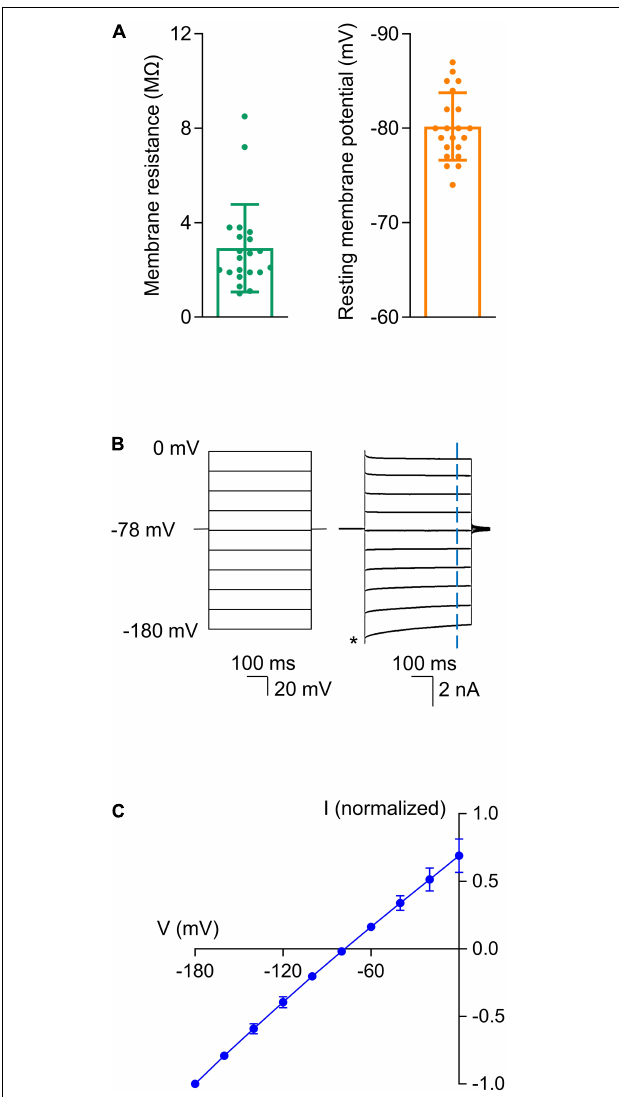
FIGURE 1 | Astrocytes displayed unique electrophysiological properties. After the whole-cell patch configuration was achieved, cells were confirmed to be astrocytes based on their low membrane resistance, hyperpolarized resting membrane potentials, and linear I-V relationships. (A) Summarized data for membrane resistance and resting membrane potential ( n = 21). (B) Linear I-V relationship of the astrocytes. Representative recordings show current responses (Right) to voltage steps (500 ms) that ranged from -180 to 0 mV in 20 mV increments (Left). The cell was held at -78 mV between voltage commands. Current amplitudes were measured 435 ms after initiation of each step voltage as indicated by the vertical blue dash line. The amplitudes were normalized to that at -180 mV as indicated by the asterisk. (C) Summarized I-V plot. Each data point represents the mean of values from 21 recorded astrocytes. The reversal potential obtained from the fitted I-V plot was -78 mV. Data are presented as mean ± SD.